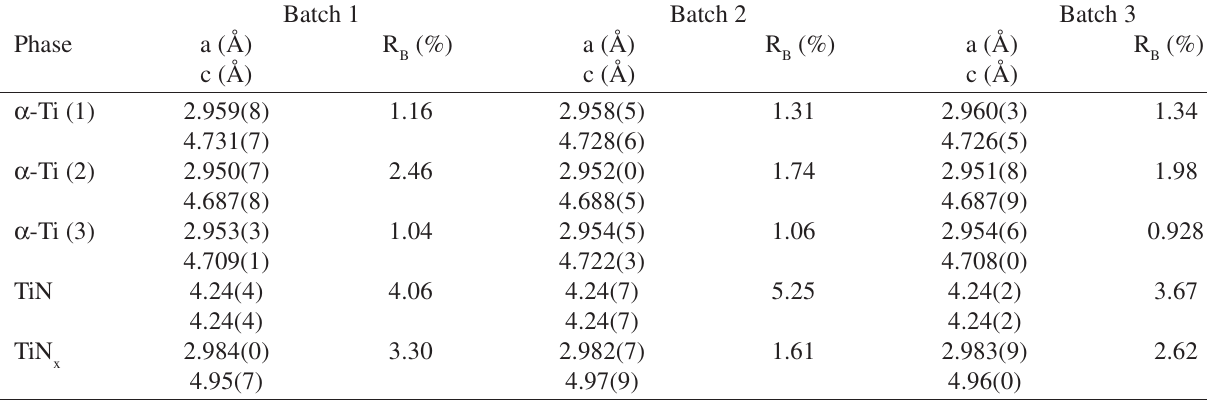
Table 1. Cell-unit parameters and agreement factor R last decimal